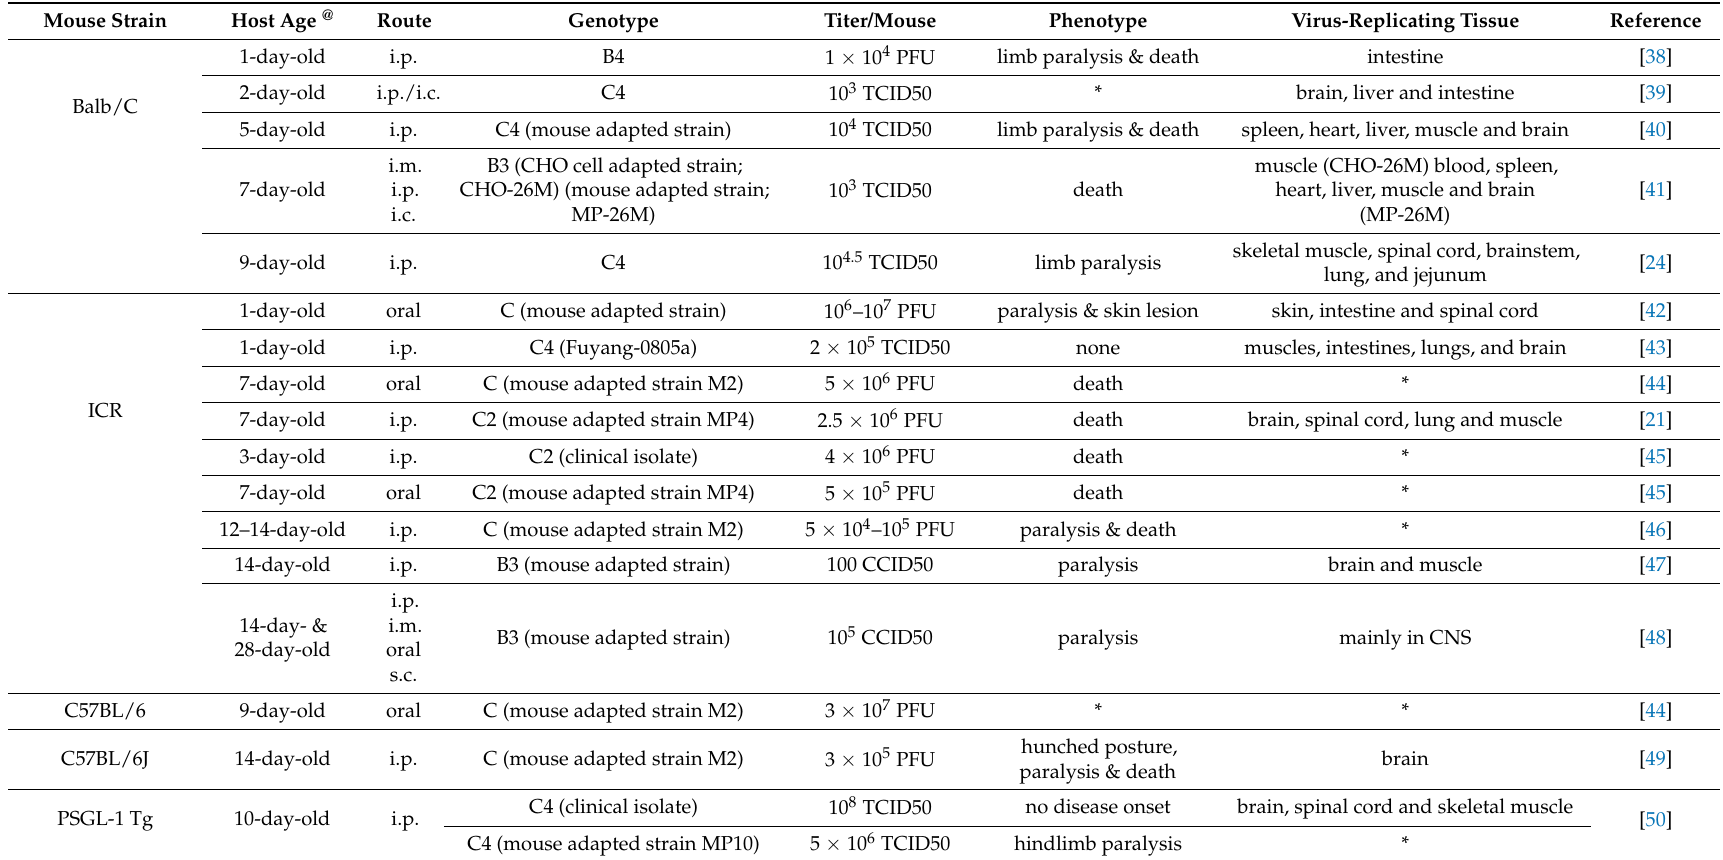
Table 2. Summary of 22 animal models used for EV71 in vivo